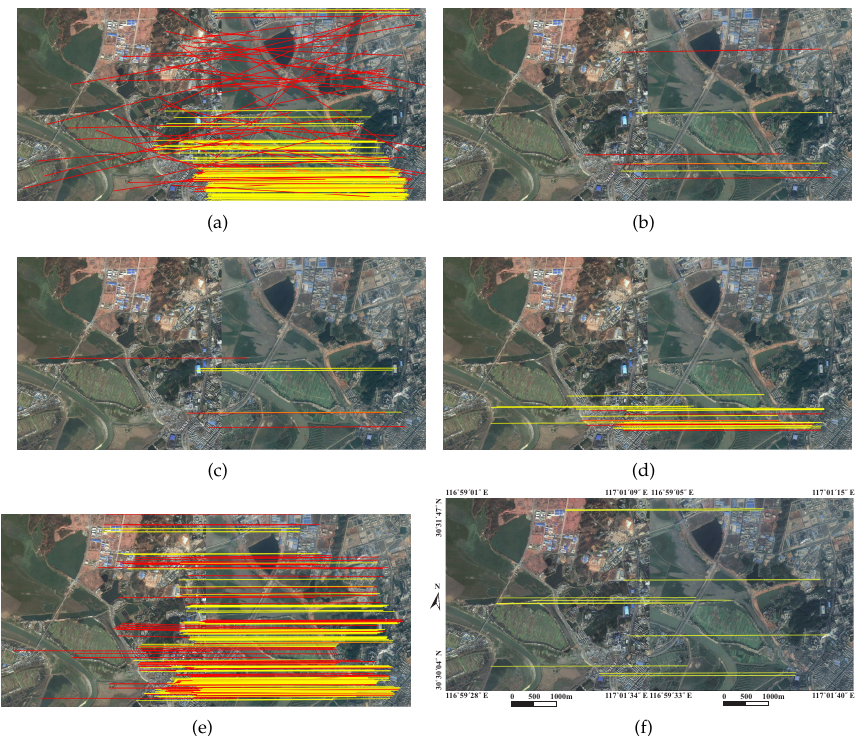
Figure 9. Matching results of image pair 1. ( a ) SIFT; ( b ) LP; ( c ) MSLD; ( d ) RLI; ( e ) LJL; ( f ) Proposed.